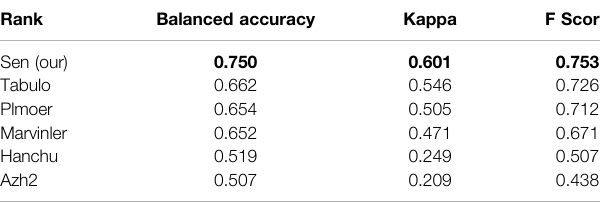
TABLE 3 | MICCAI 2020 CPM-RadPath fi nal scores and ranking in the test